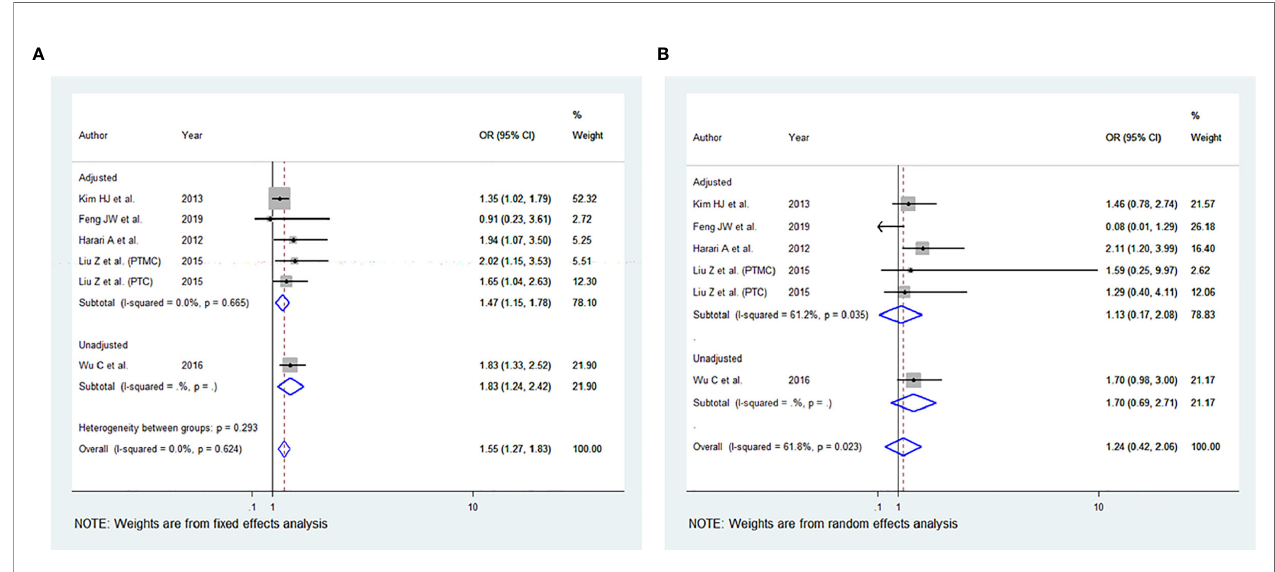
FIGURE 2 | Forest plots for the meta-analysis for the association between Body Mass Index and Advanced Tumor-Node-Metastasis (TNM) stage. (A) Meta-analysis between overweight and advanced TNM stage. (B) Meta-analysis between obesity and advanced TNM stage.